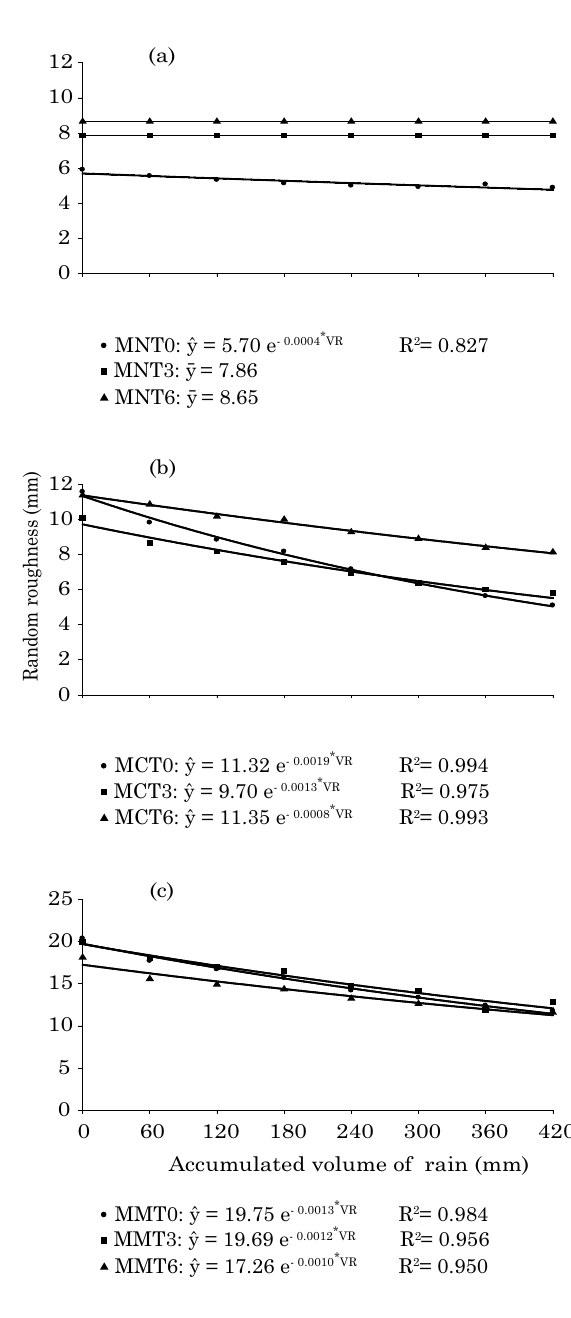
Figure 2. Random roughness of the soil surface (RR) as a function of the accumulated volume of rain (VR) under different rates of maize residue: (a) no tillage; (b) conventional tillage; and (c) minimum tillage. * significant at 5 % by the t